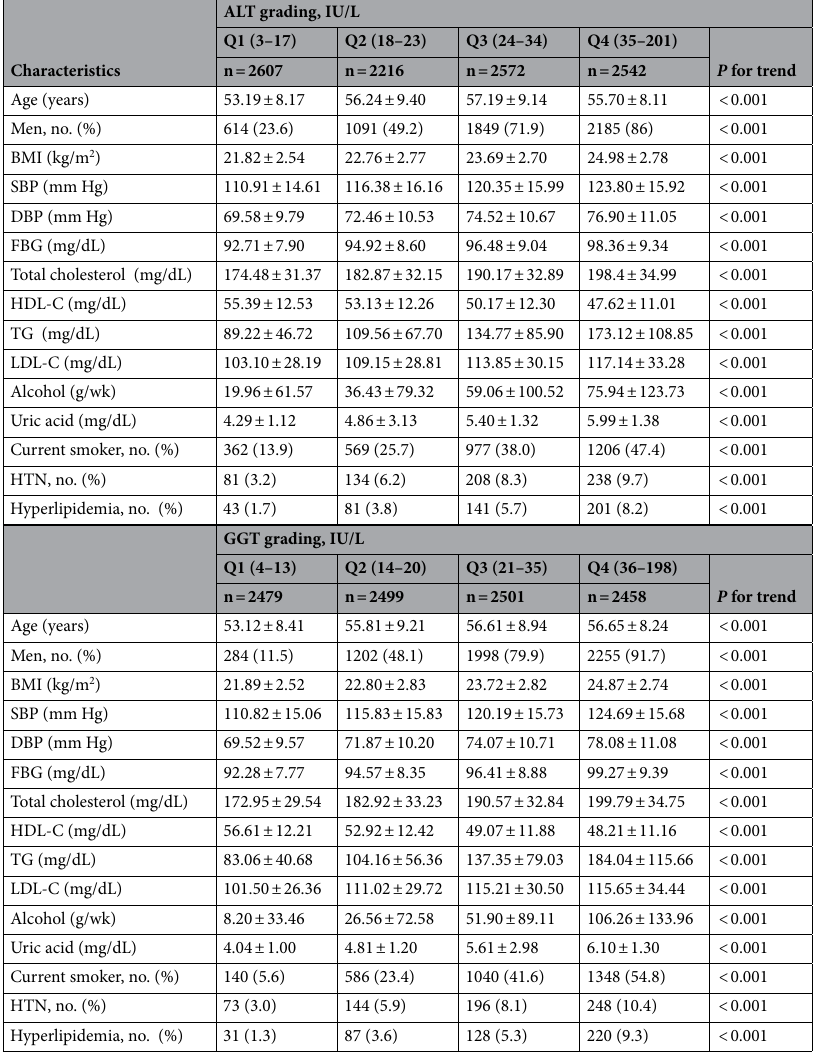
Table 1. The general characteristics of the study subjects by serum alanine aminotransferase and gamma- glutamyltransferase grading in cross-sectional analysis. Q1 1st quartile, Q2 2nd quartile, Q3 3rd quartile, Q4 4th quartile, ALT alanine aminotransferase, BMI body mass index, SBP systolic blood pressure, DBP diastolic blood pressure, FBG fasting blood glucose, HDL-C high-density lipoprotein cholesterol, TG triglycerides, LDL- C lowdensity lipoprotein cholesterol, HTN hypertension, GGT